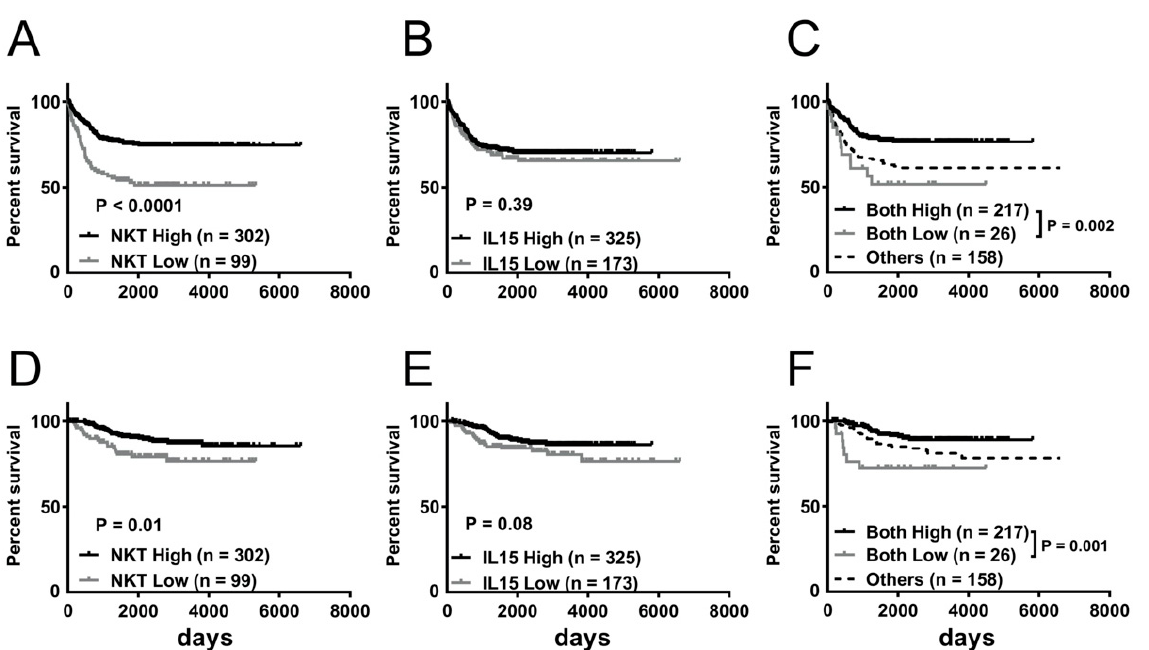
Figure 3. Survival benefit of greater abundance of NKT and IL-15 expression in MYCN-non-amplified NBL dataset GSE49711. Kaplan–Meier curves showing EFS ( A–C ) and OS ( D–F ) of MYCN non-amplified NBL according to NKT immunoscore ( A , D ), IL-15 expression ( B , E ), and combined NKT immunoscore and IL-15 expression ( C , F ). Log-rank test was applied for statistical comparison.